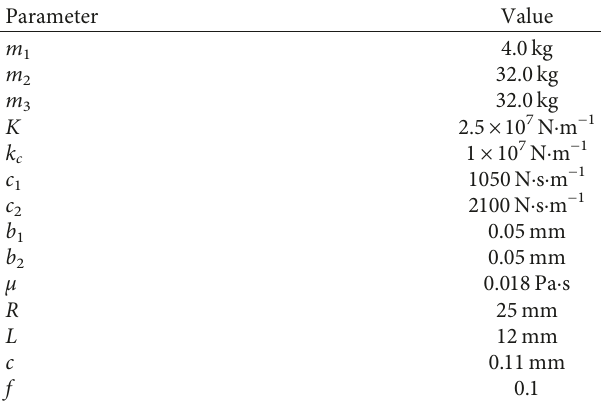
Table 1: Parameters of the rotor system. Parameter